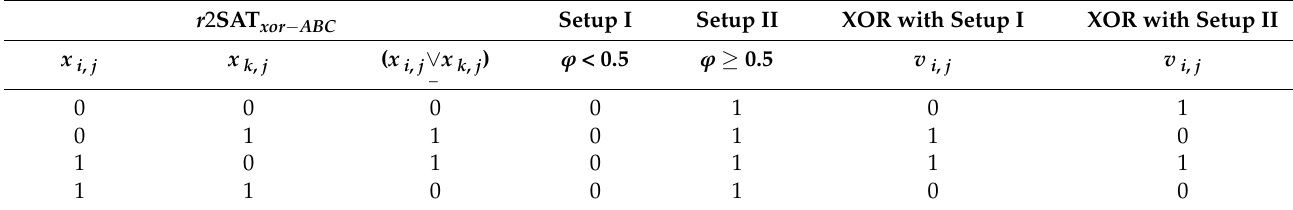
Table 10. The implication truth table for XOR.